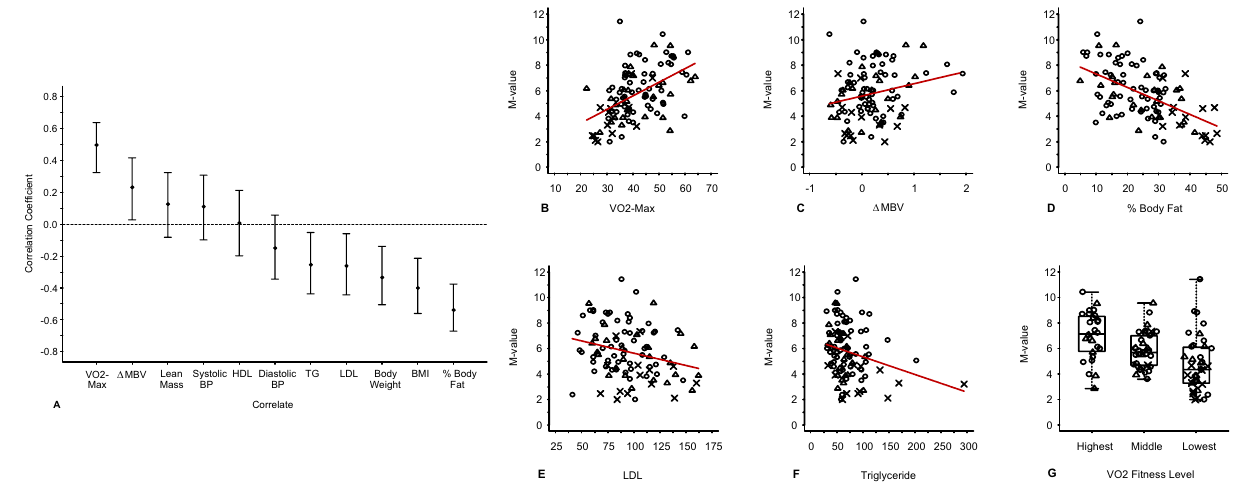
Figure 1. Bivariate relationships between M-value and prediction variables. ( A ) Pearson correlations between M-value and subject characteristics. The vertical lines indicate the 95% confidence interval for the correlation coefficient. ( B – F ) Relationships between M-value and individual predictor variables. The red lines represent the ordinary least squares linear regressions. ( G ) Relationship between M-value and cardiorespiratory fitness. ΔMBV, insulin-mediated change in muscle microvascular blood volume; BMI, body mass index; BP, blood pressure; HDL, high-density lipoprotein cholesterol; LDL, low-density lipoprotein cholesterol; TRI, triglycerides; VO 2 max, maximum consumption of oxygen (mL/kg/min); VO2 fitness, level of cardiorespiratory fitness by tertile. Plotting symbols: Healthy°, Obese ˟ , Type 1 diabetes Δ CI [− 0.64, − 0.28], p < 0.001). Furthermore, given the moderate correlation between VO 2 max and M-value, the cohort was divided into 3 tertiles of cardiorespiratory fitness based on sex, age, and VO 2 max. As expected, sub- jects in the highest fitness tertile had the highest mean M-value (7.0 ± 0.4 mg/kg/min) while those in the middle fitness tertile had the second highest mean M-value (5.9 ± 0.3 mg/kg/min), and those in the lowest tertile had the lowest mean M-value (4.7 ± 0.4 mg/kg/min). Between tertile comparisons of mean M-value showed significant differences between highest and middle fitness tertile groups (p = 0.013), between highest and lowest fitness tertile groups (p < 0.001), and between the middle and lowest fitness tertile groups (p = 0.002). Analyzing the association between ΔMBV and phenotypic variables (Fig. 2), only M-value (r = 0.23, 95% CI [0.03, 0.42], p = 0.023) and VO 2 max (r = 0.20, 95% CI [0.00, 0.39], p = 0.047) correlated with ΔMBV. The other variables including measures of body weight and body composition, LDL-C, triglyceride, and baseline insulin levels, which correlated with M-value, did not correlate with ΔMBV. There was no difference among the fitness tertiles in terms of ΔMBV (p = 0.23, Fig. 2G). There was also no significant correlation between fasting plasma insulin levels and ΔMBV in the subjects without type 1 diabetes (r = − 0.18; 95% CI [− 0.4, 0.05], p = 0.12). The multivariate regression model type III ANOVA F-tests for testing the null hypothesis is presented in Table 2. With respect to M-value, the metabolic insulin resistance risk factors as a unit provided significant predictive value. Both plasma triglyceride levels and ΔMBV were unique predictors of M-value. With respect to ΔMBV, the metabolic insulin resistance risk factors as a unit did not provide significant predictive information. Only M-value independently predicted ΔMBV. Despite the positive association between VO 2 max and M-values and the positive association between VO 2 max and ΔMBV, cardiorespiratory fitness tertile did not provide sig- nificant predictive information about M-value or ΔMBV. M-values and ΔMBV were compared between males and females to assess for any sex difference. As expected, our study participants had a large range of insulin sensitivity patterns. Thus, the glucose infusion rates during insulin clamp spanned over a large range for both men and women and the ∆MBV responses ranged from marked increase, no change to even a decrease (Fig. 3). Based on total body weight, females had a lower M-value compared with men (5.25 ± 0.28 vs. 6.21 ± 0.29 mg/kg/min, p = 0.038), but this difference disappeared after lean body mass correction (Fig. 3A). There was clearly no difference in mean ΔMBV between males and females